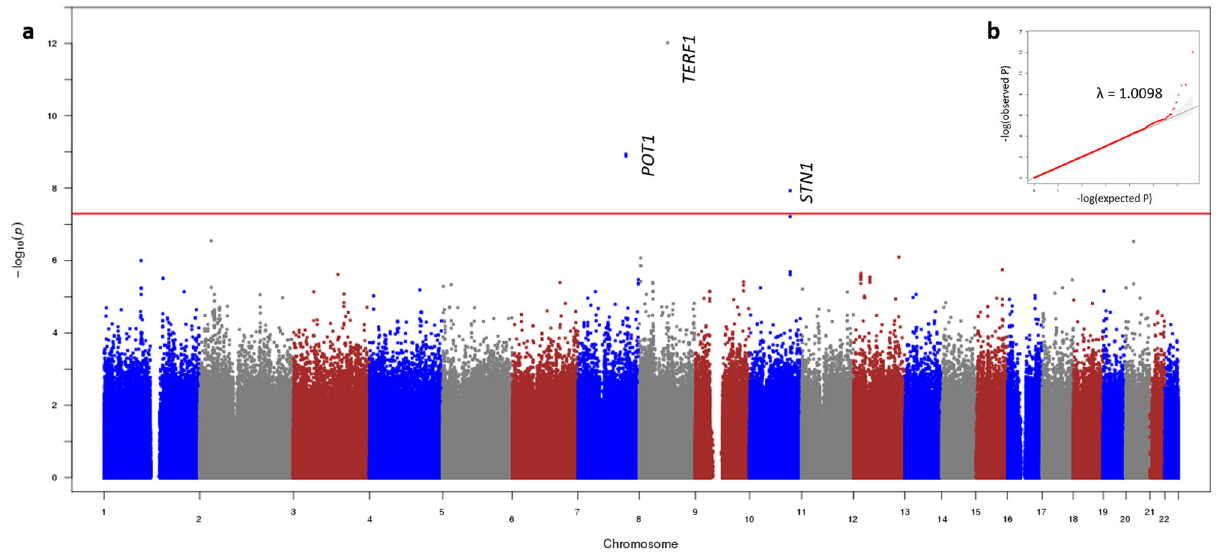
Fig. 1 Low-frequency LTL associations in the SCHS Discovery dataset ( N = 20,177). a Three loci at chromosome 7, 8, and 10 were identi fi ed beyond the genome-wide signi fi cance threshold (score test P < 3.117 × 10 − 8 , red line). b QQ-plot of observed compared to expected P -values indicated minimal in fl ation of study results ( λ =